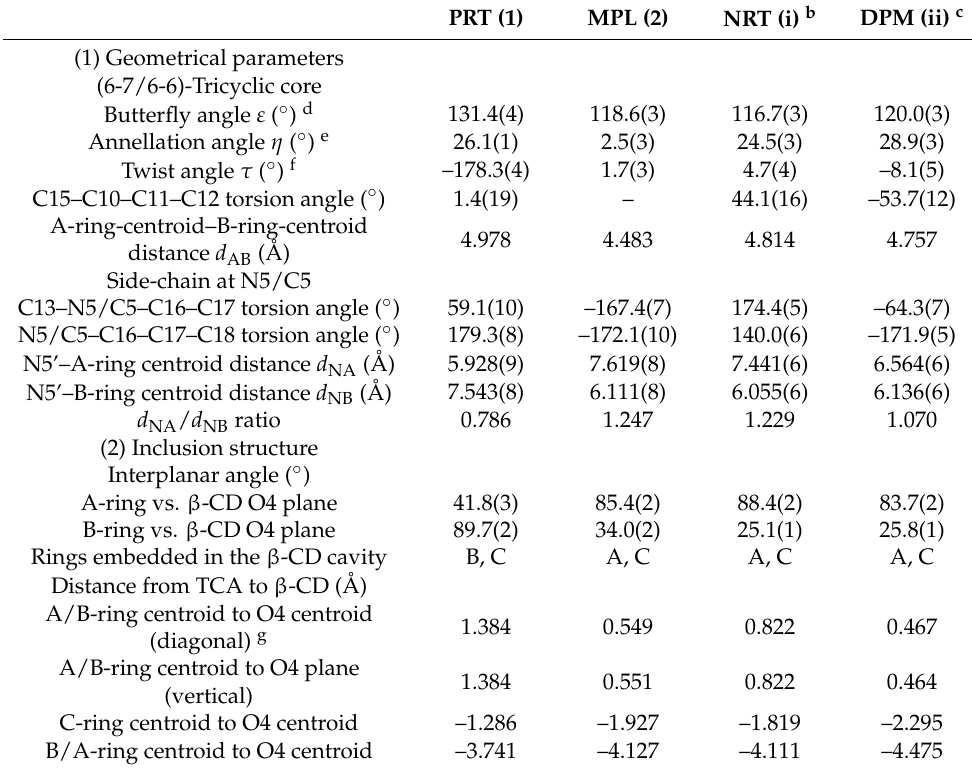
Table 2. Comparisons of geometrical parameters and inclusion structures of four 2 ◦ amine TCAs embedded in the β -CD cavity, PRT ( 1 ), MPL ( 2 ), NRT (i), and DPM (ii) a